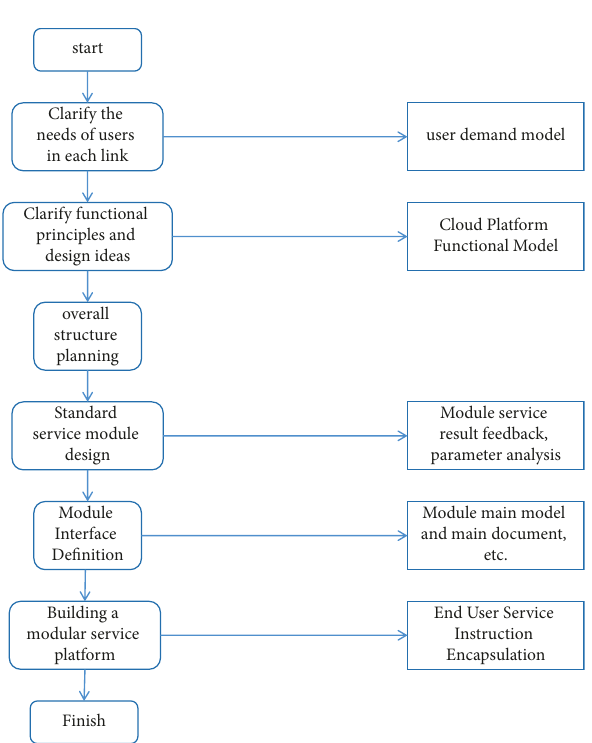
Figure 5: Schematic diagram of noncircular gear